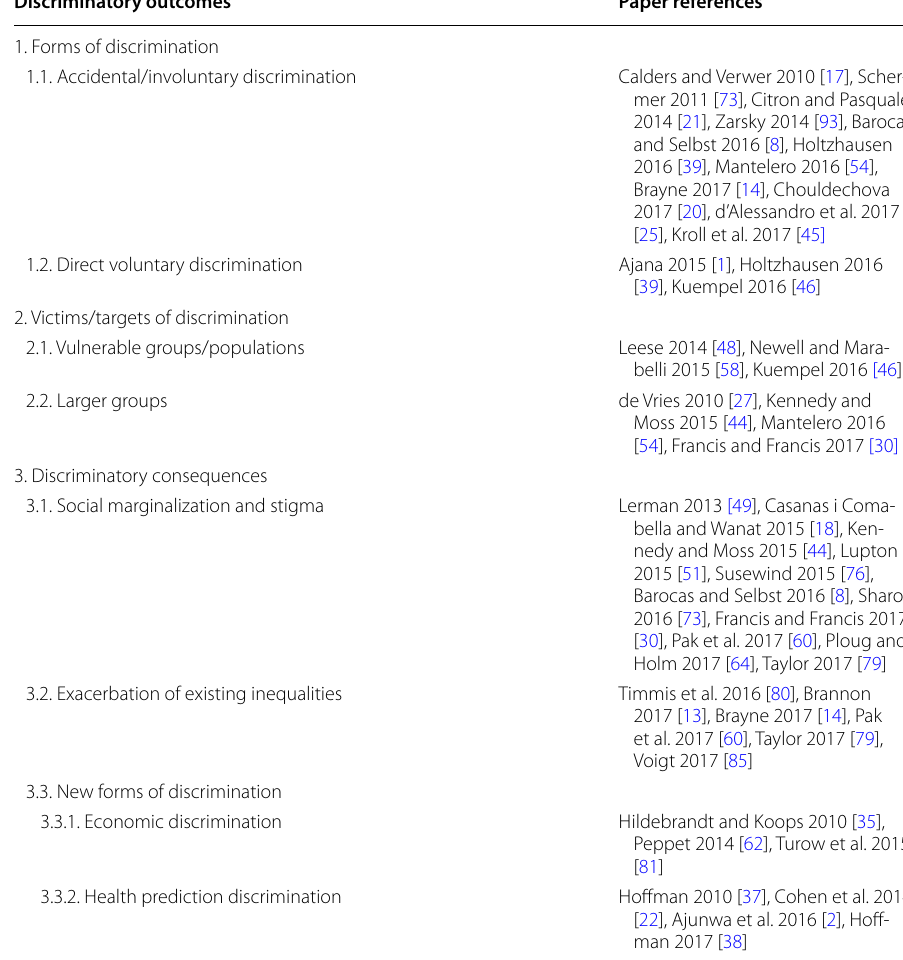
Table 3 Discriminatory outcomes of Big Data Discriminatory